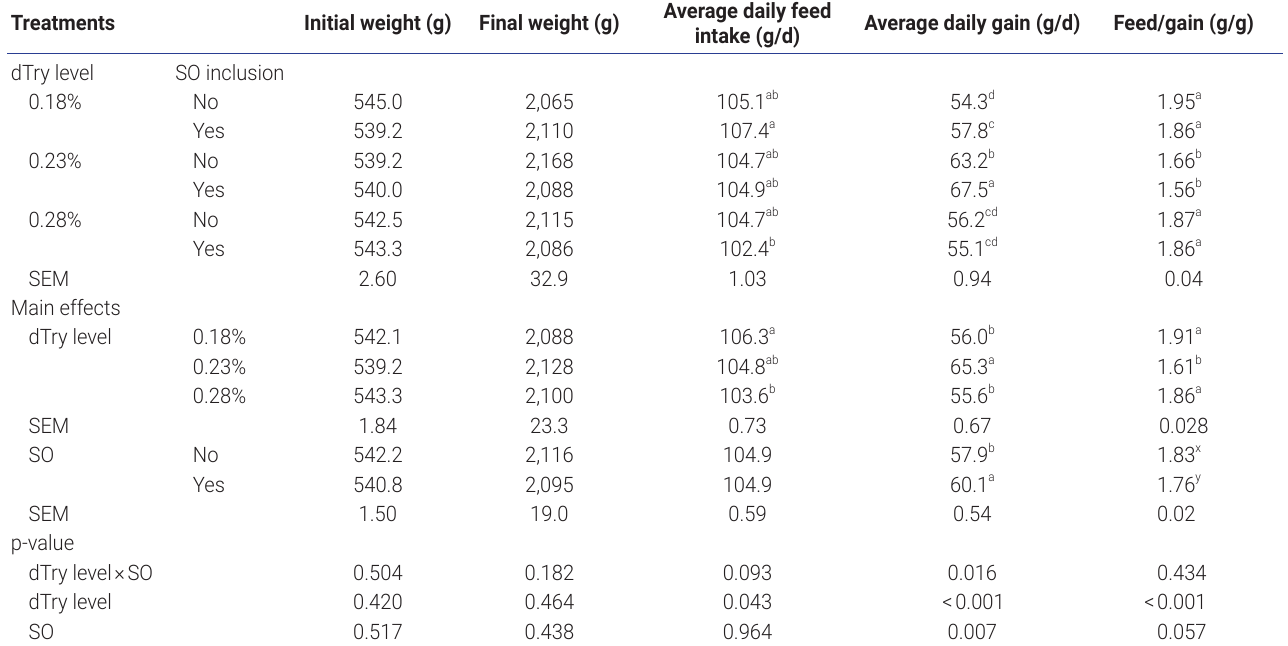
Table 2. Effects of dietary digestible tryptophan (dTry) and soy oligossacharide (SO) supplementation on growth performance of broilers aged from 14 to 42 days